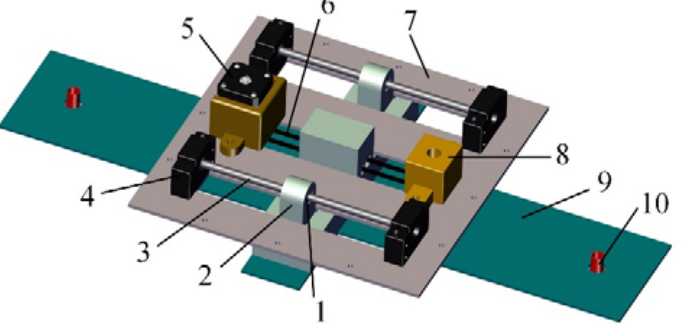
Figure 4. Targeting device structure.